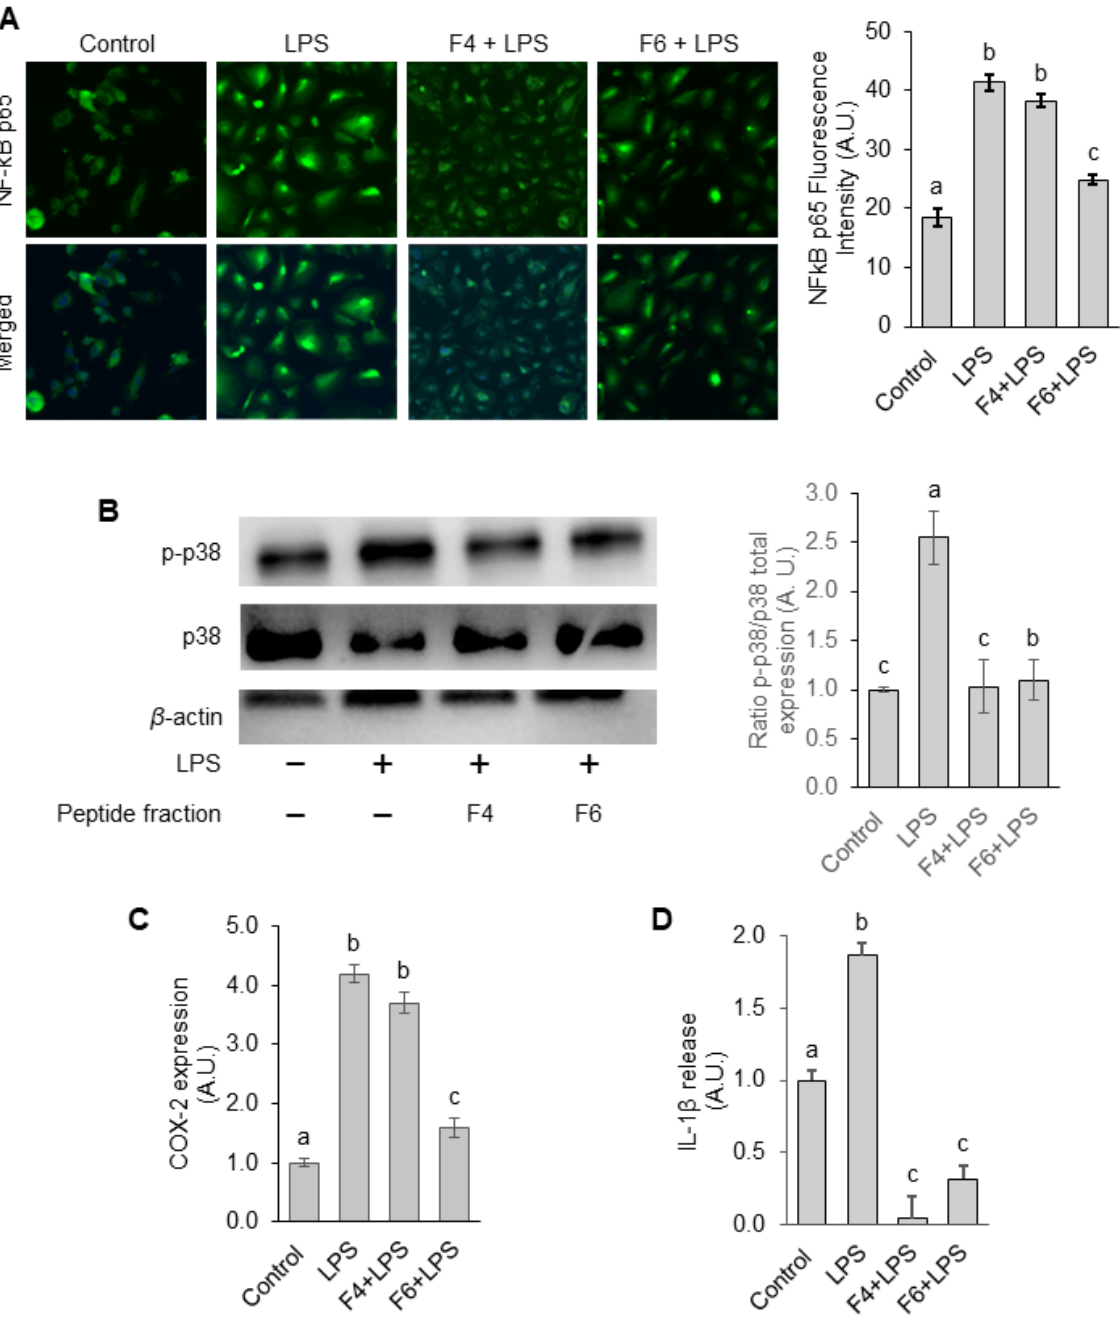
Figure 5. Effects of F4 and F6 on LPS ‐ induced inflammatory processes in endothelial cells. ( A ) NF ‐ κ B p65 nuclear translocation was evaluated by confocal microscopy after 3 h of LPS stimulation. Images were captured and p65 nuclear translocation quantified using ImageJ software. ( B ) Phosphorylation of p38 MAPK was measured by immunoblotting. Protein bands of phospho ‐ p38 were normalized to the total form and the values in the groups were relative values to the control group. Protein bands were quantified by densitometry and normalized to their respective loading controls. ( C , D ) COX ‐ 2 protein expression and IL ‐ 1 β secretion at 12 h of LPS stimulation were assessed by ELISA assay. The protein level in the control group was set as 1 and the values in the other groups were relative values to the control group. Statistical difference ( p < 0.05) is denoted by letters a–c. Shared letters indicate no significant